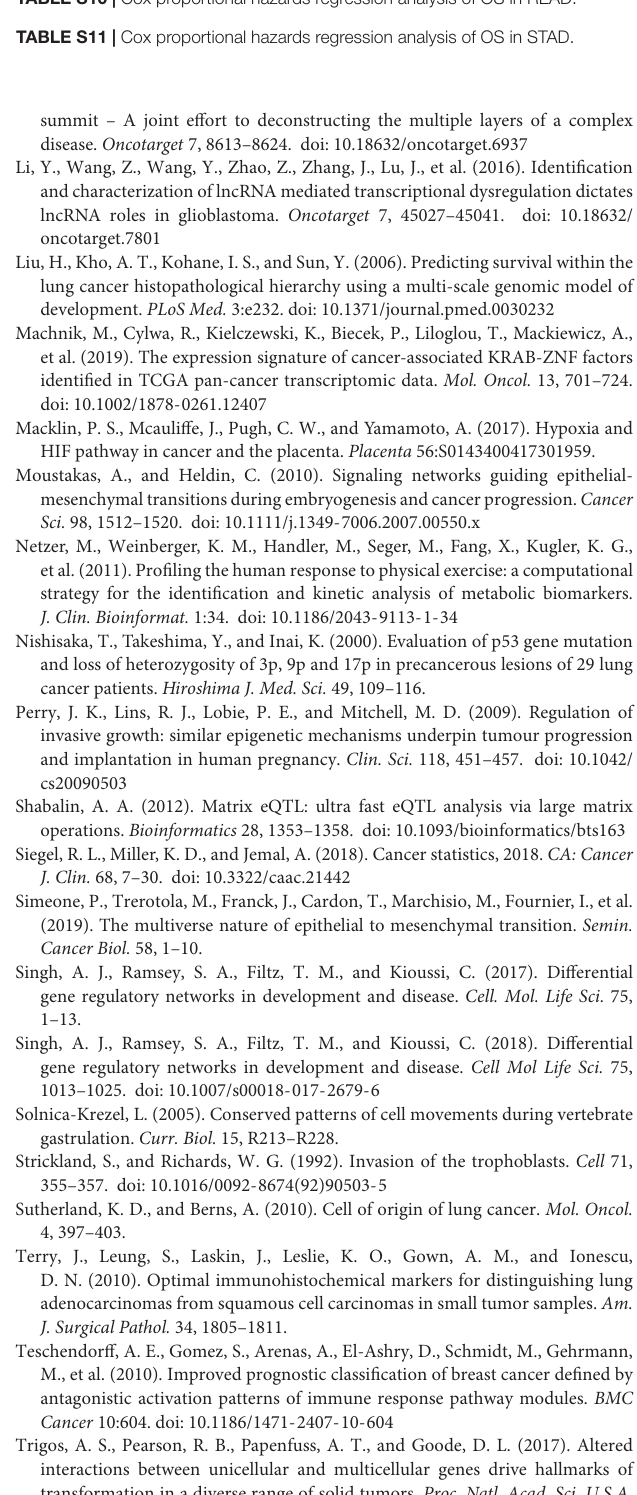
TABLE S8 | Cox proportional hazards regression analysis of OS in HNSC. TABLE S9 | Cox proportional hazards regression analysis of OS in LUAD. TABLE S10 | Cox proportional hazards regression analysis of OS in READ. TABLE S11 | Cox proportional hazards regression analysis of OS in